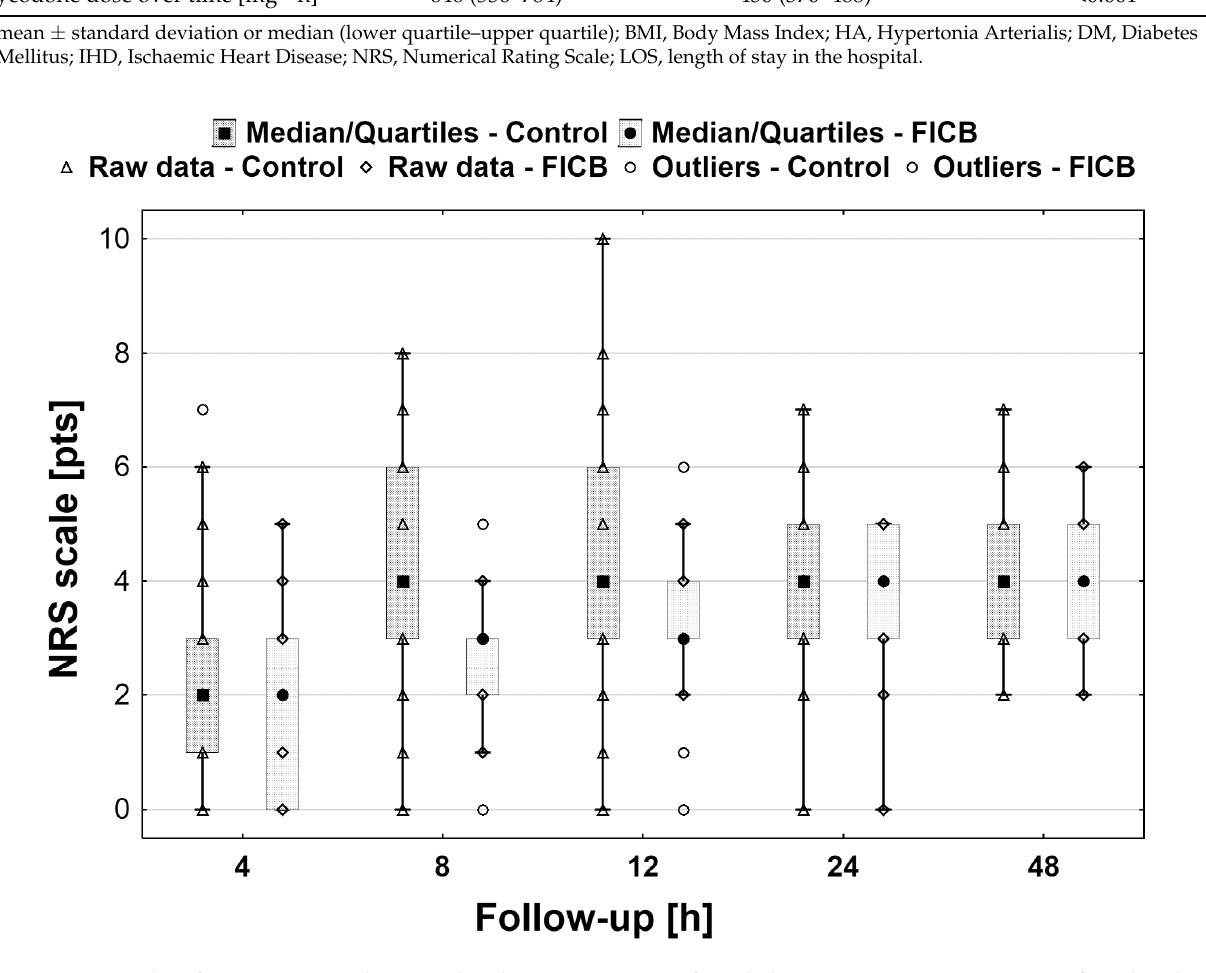
Figure 2. Box-plot of resting NRS in the control and FICB group. Significantly lower resting NRS scores were found in the FICB group at all time points except for 48 h.